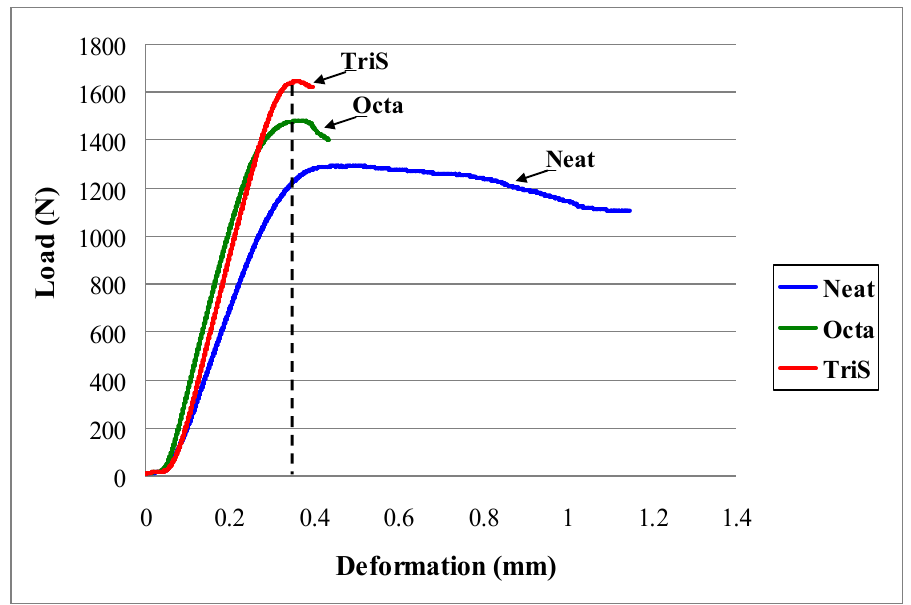
Figure 2. Short beam shear testing results.